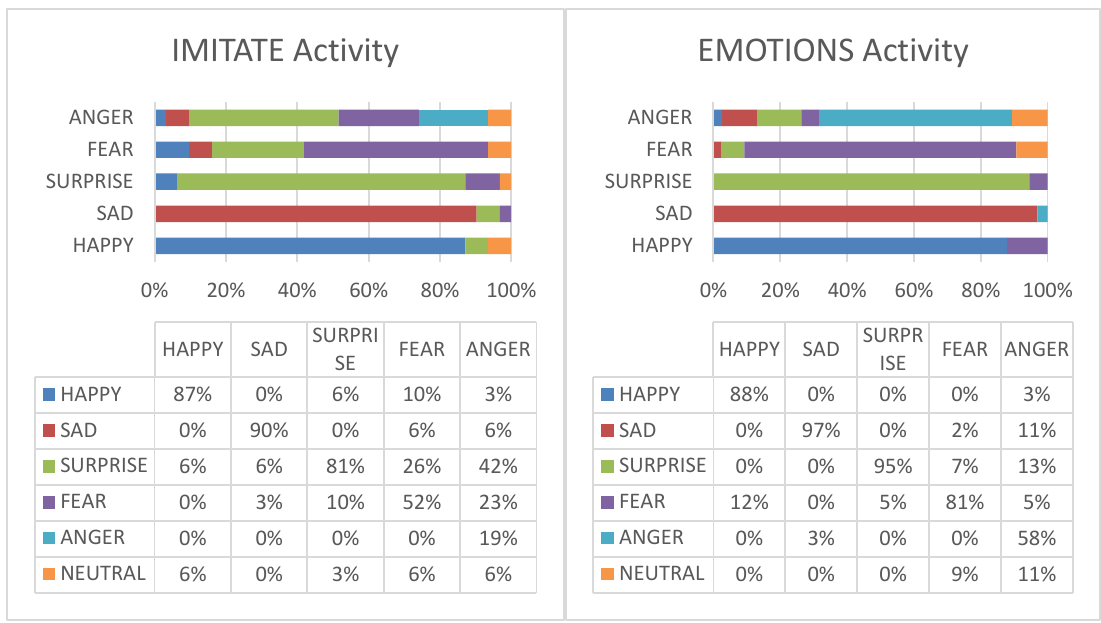
10 of 19 Figure 3. Experimental configuration: Child – ZECA – Researcher. The quantitative behaviours analysed were the following: number of right and wrong answers and the children ’s response time. The response time was counted from the time the robot gave the prompt to the time the child performed the correspondent